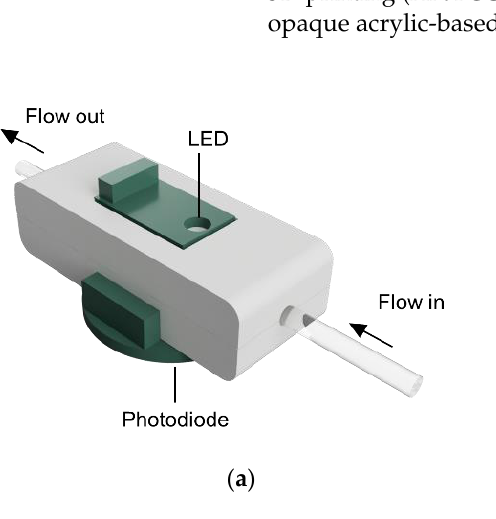
Figure 5. On-line pH monitoring system. ( a ) a CAD file of a pH sensor; ( b ) a photo of a pH sensor with green LED.